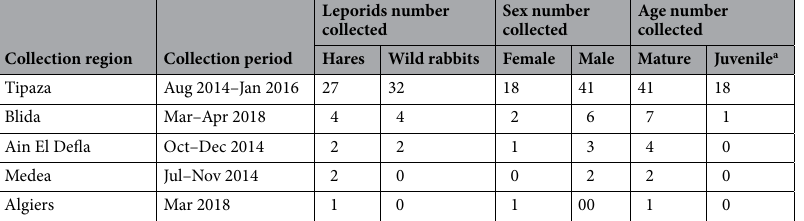
Table 1. Characteristics of collected wild rabbits and Cape hares. a The positive juvenile was a wild rabbit.